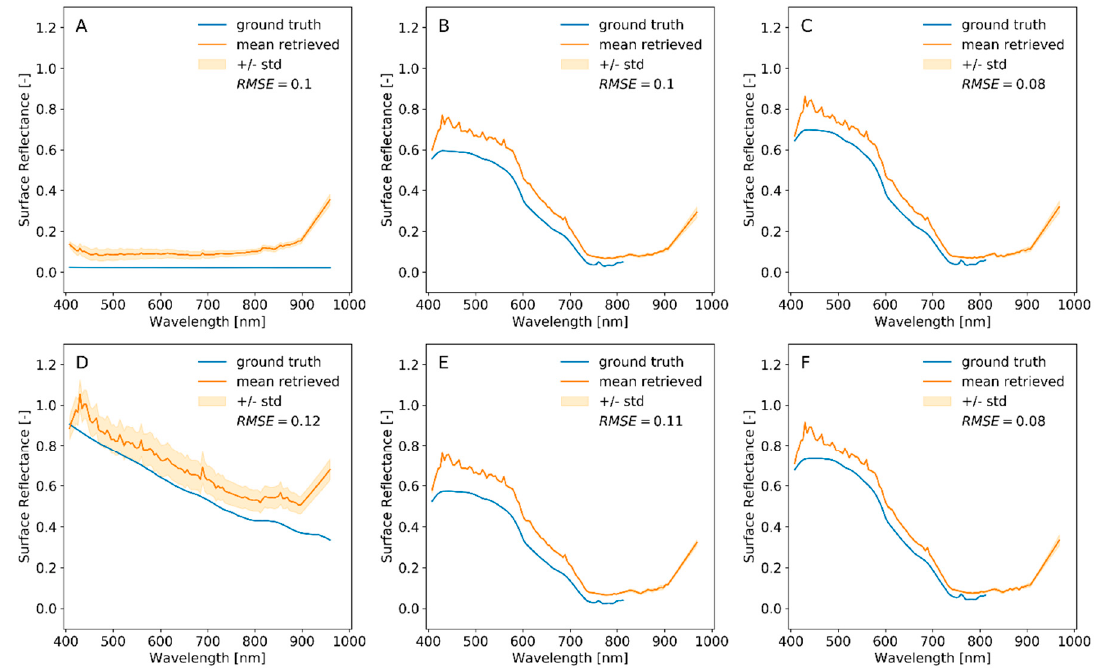
Figure 4. Comparison between Atmospheric and Topographic Correction (ATCOR) and field spectra for the dark ( A ) and bright ( D ) targets and four melt pond buffers ( B , C , E , F ). Root-mean-square error ( RMSE ) is computed for the overlapping wavelength regions. In the wavelength region between 670 nm and 750 nm, RMSE for the dark and bright spectra are 0.07 and 0.1, respectively. The RMSE for the pond spectra is between 0.05 and 0.07. Figure 5 illustrates that a peak at ~ 689 nm characterizes all spectra.